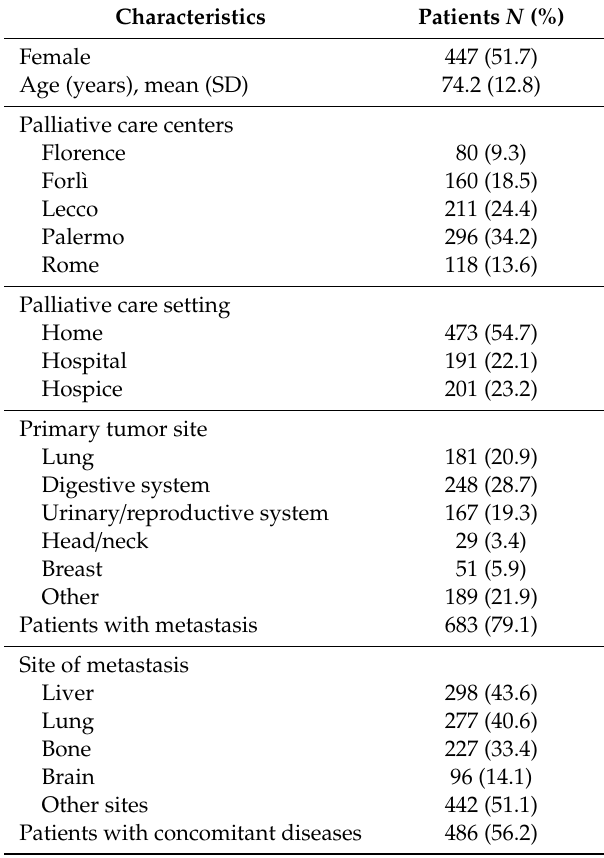
Table 1. Demographic and clinical characteristics of the 865 study patients at